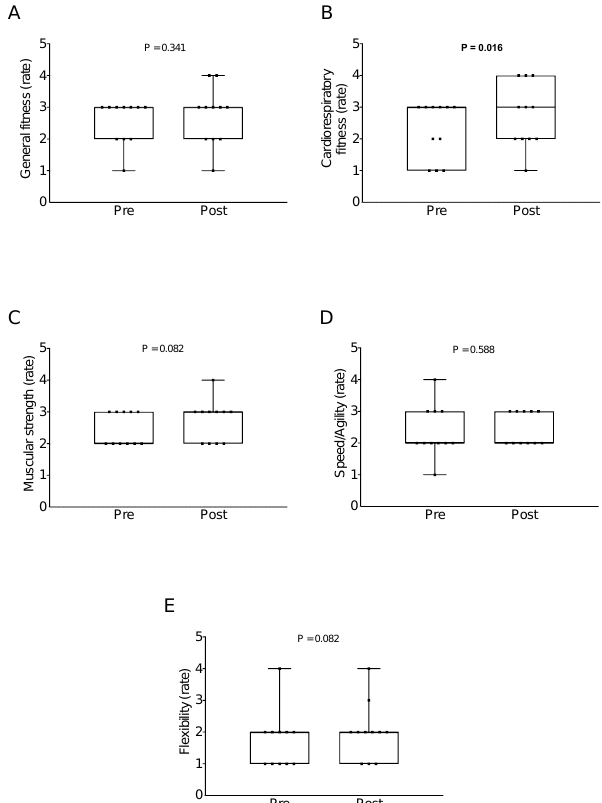
Figure 3. Changes in physical fitness (i.e., general fitness ( A ), cardiorespiratory fitness ( B ), muscle strength ( C ), speed/agility ( D ), and flexibility ( E )) after the bicycle touring intervention. p value derived from paired t -test. Data are shown as mean ± 95% confident intervals. We showed a lack of association between changes in fat mass (i.e., post-intervention minus baseline) and BMI baseline values ( R = −0 .135; p = 0.659; Figure 4). We also showed a lack of association between changes in lean mass (i.e., post-intervention minus baseline) and BMI baseline values (R = 0.096; p = 0.754; Figure 4).